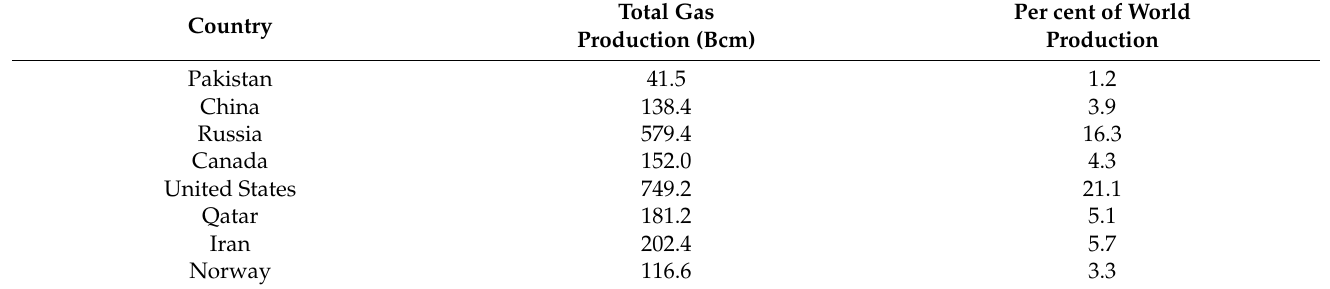
Table 1. Natural-gas production of the major gas producing countries compared with Pakistan [4].